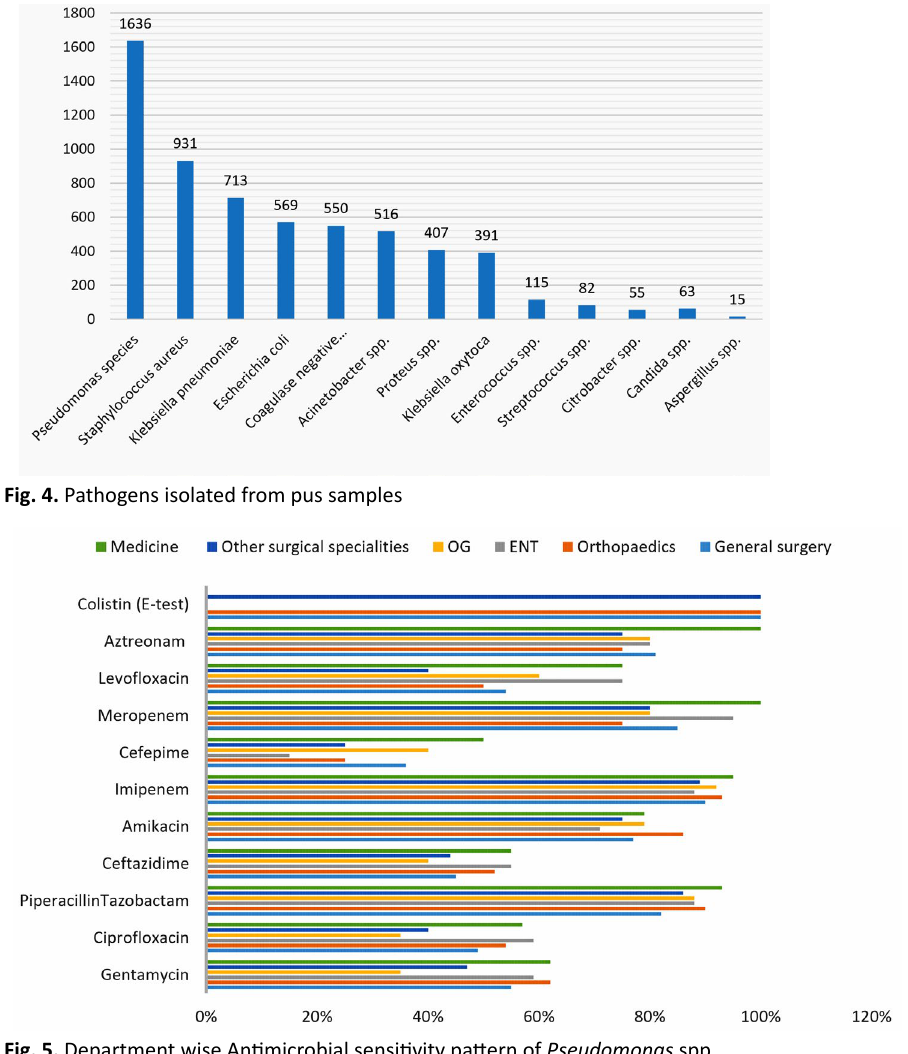
Fig. 5. Department wise Antimicrobial sensitivity pattern of Pseudomonas